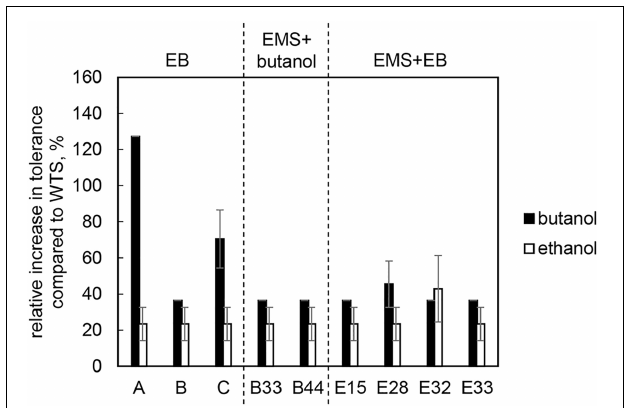
FIGURE 2 | Relative increase in butanol and ethanol tolerance of mutant strains compared to C. beijerinckii NRRL B-598 (WTS). Tolerance levels are expressed as the maximum concentration of butanol or ethanol in TYA medium at which growth of the strains was still detectable. The original tolerance of WTS to butanol and ethanol was 11 ± 1 g/L and 38.5 ± 2.1 g/L, respectively. EB – strains obtained by random chemical mutagenesis using EB as a mutagenic agent, when strains were selected directly on the agar plates containing EB; EMS + butanol – strains obtained by random chemical mutagenesis using EMS with selection on butanol; EMS + EB – strains obtained by random chemical mutagenesis using EMS with selection on EB.